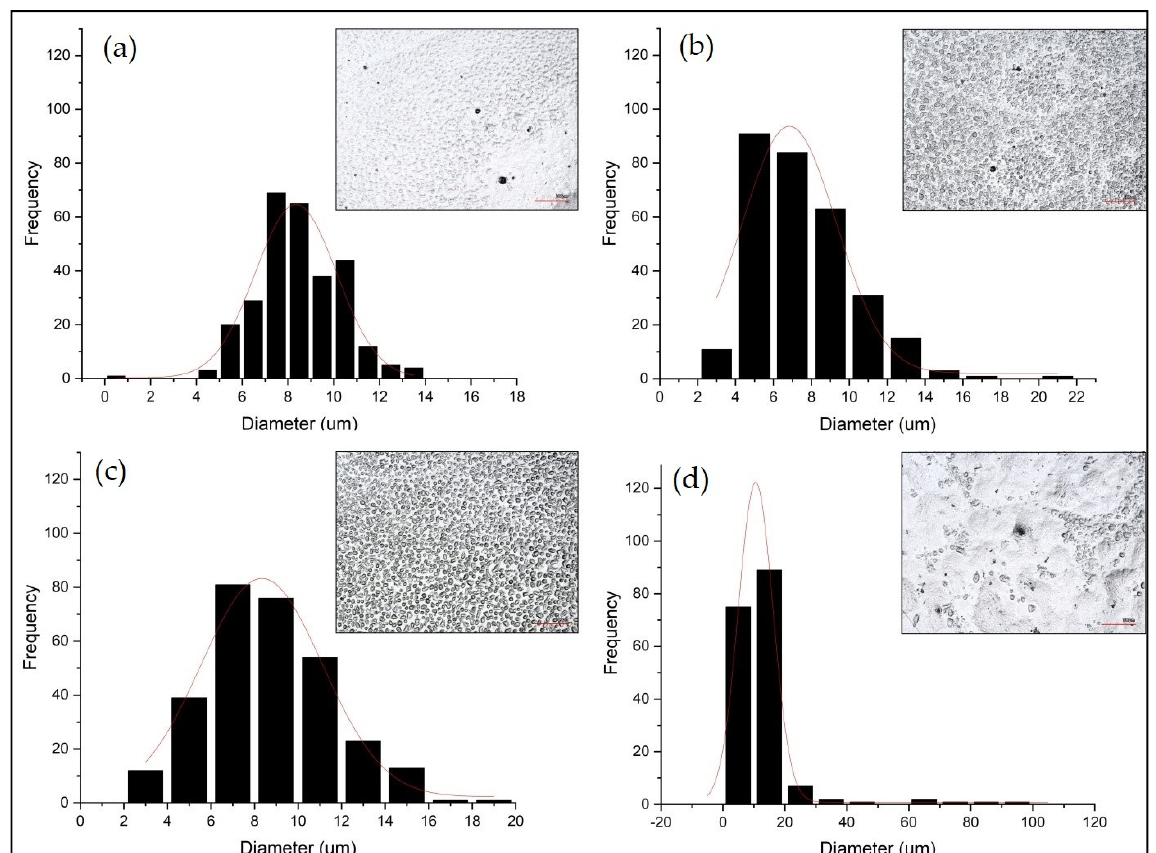
Figure 1. Histograms and Gaussian functions resulting from 3D image processing (top right image in each graph): samples aged at RH 80% with ( a ) H 2 S, ( b ) SO 2 , ( c ) O 3 , and ( d ) NO x .